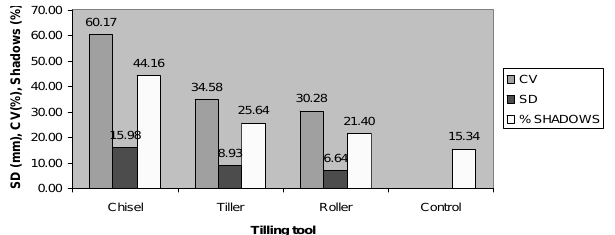
Figure 10. Fig. 10. Shadow analysis and pin meter results in the field, includ- ing percentage of shadows, CV, SD, and surface roughness mea- surements depending on tilling tools. The control was measured using shadows analysis and the chain set